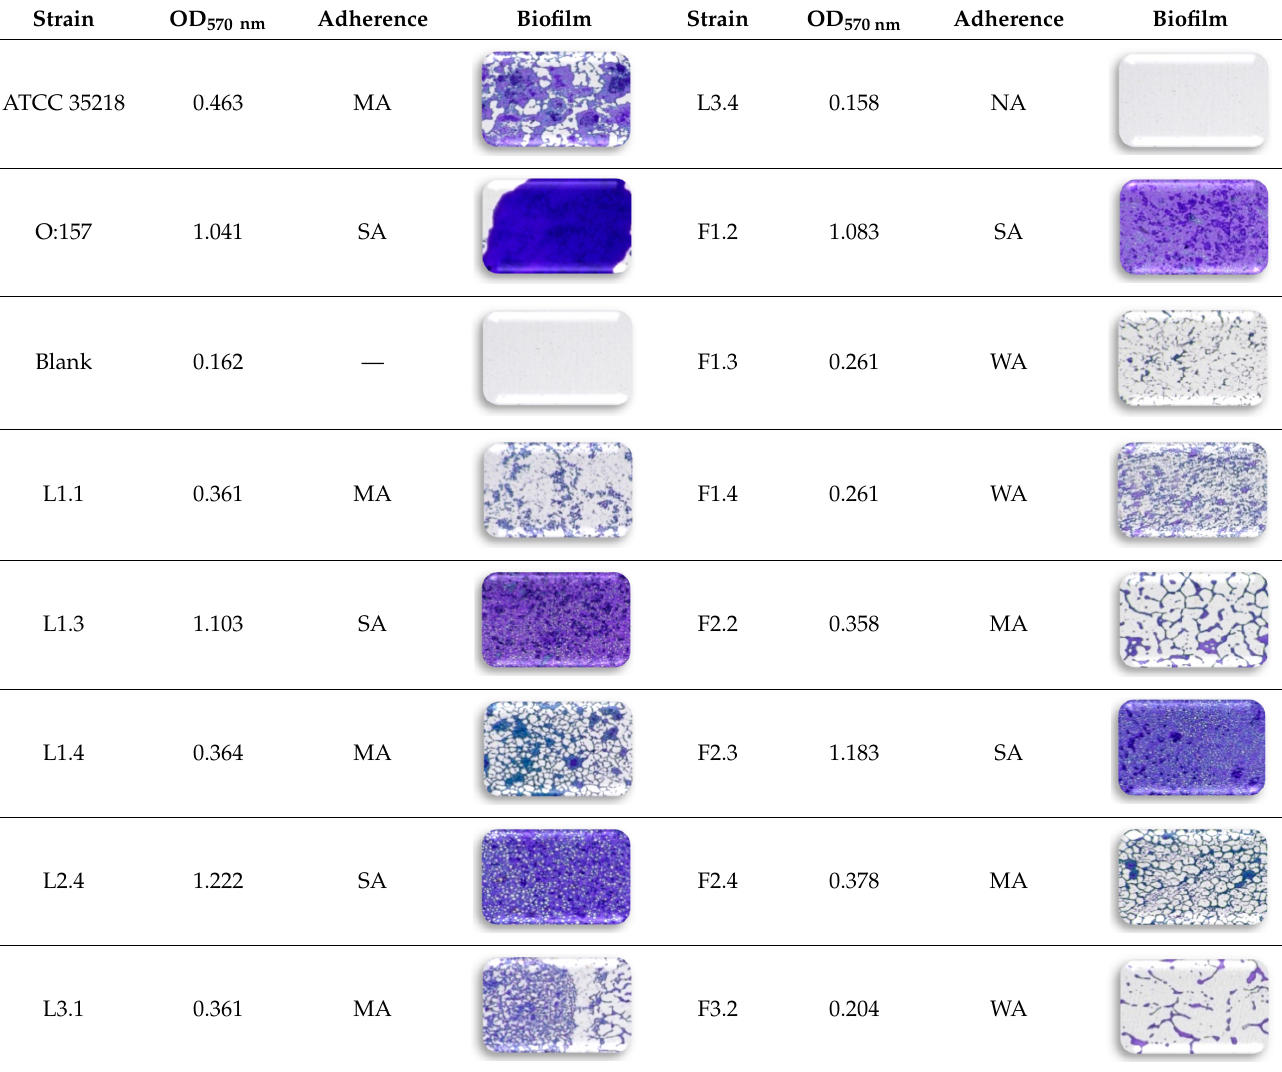
Table 1. Adherence of the isolated E. coli from lagoons and faeces, compared with those of the controls. Strain OD 570 nm Adherence